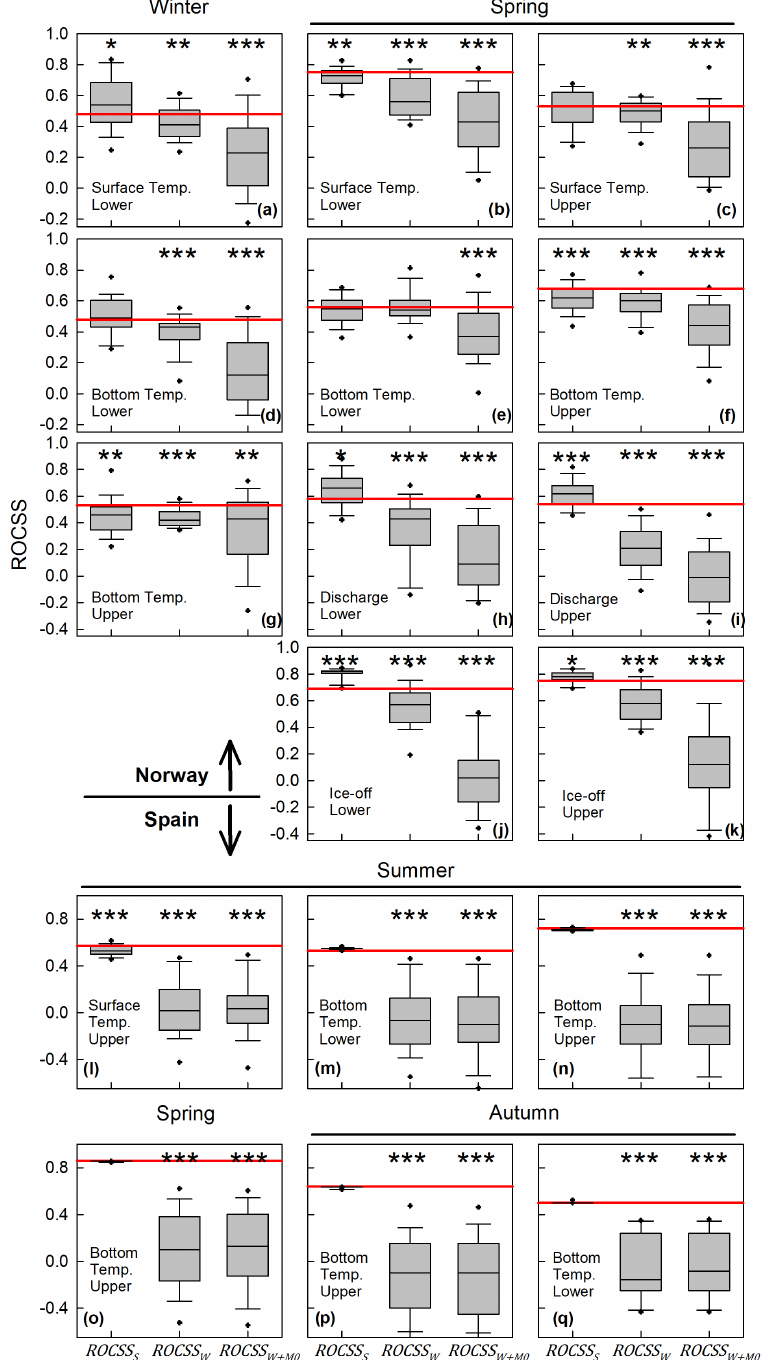
Figure 4. Box plots ( n = 25) of ROCSS S , ROCSS W and ROCSS W + M0 from sensitivity analysis runs S-SA (replacing target season SEAS5 data with random data), W-SA (replacing warm-up ERA5 data with random data) and W + M0-SA (replacing warm-up period – ERA5 and first lead month – SEAS5 data with random data) for each window of opportunity at the Norwegian (a–k) and Spanish (l–q) sites. ROCSS original is given by the red line, so ROCSS S , ROCSS W and ROCSS W + M0 below the red line indicate a loss of skill, and values above the line indicate higher skill than the original forecast. ∗∗∗ , ∗∗ and ∗ indicate significant difference between a given group of ROCSS S , ROCSS W and ROCSS W + M0 values and ROCSS original following a Mann–Whitney rank sum test at a significance level of 0.001, 0.01 and 0.05, respectively. Note that the S-SA, W-SA and W + M0-SA were only performed for Sau Reservoir in Spain and Lake Vansjø in Norway because of the significant resources needed to perform these hindcast